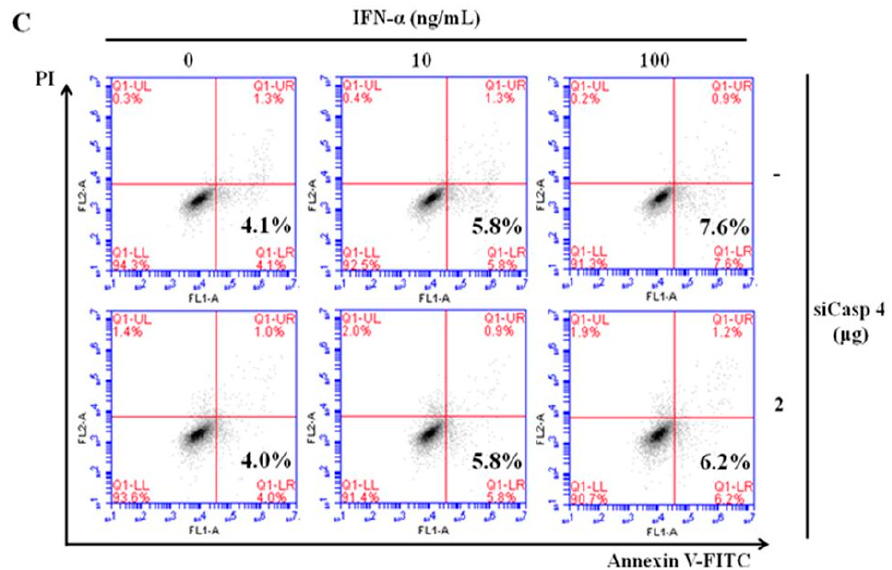
Figure 5. Knocking down the endogenous caspase 4 expression by caspase 4 small interfering RNA (siCasp 4) reduces IFN- α -mediated HeLa cell apoptosis. ( A ) The inhibitory effect of siCasp 4 on endogenous caspase 4 mRNA expression. HeLa cells were transiently transfected with increasing doses (0, 2, and 4 μ g) of siCasp 4 for 48 h. Real-time qRT-PCR was conducted to measure the endogenous levels of caspase 4 mRNAs. Each value is represented as mean± SD from three